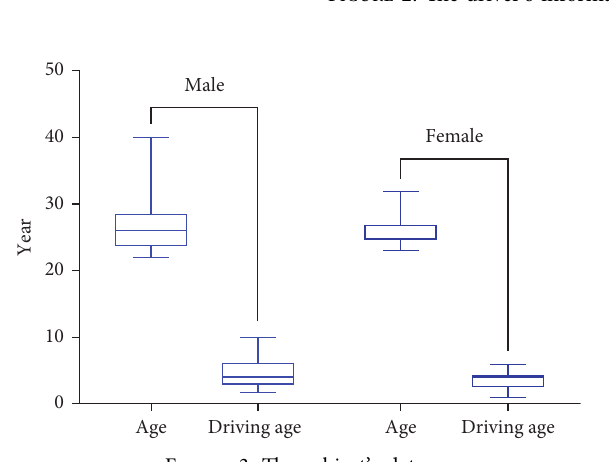
Figure 3: The subject’s data.